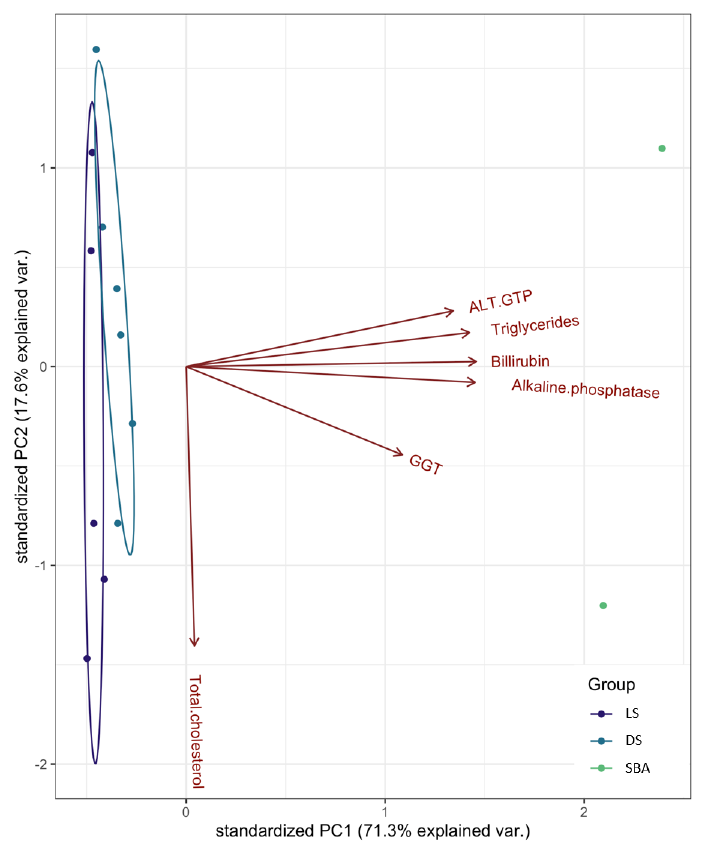
Figure 4. Principal component analysis (PCA) biplot of biomarker concentrations as a function of shark groups (LS—live sharks, DS—dead sharks, SBA—sharks with bile accumulation).